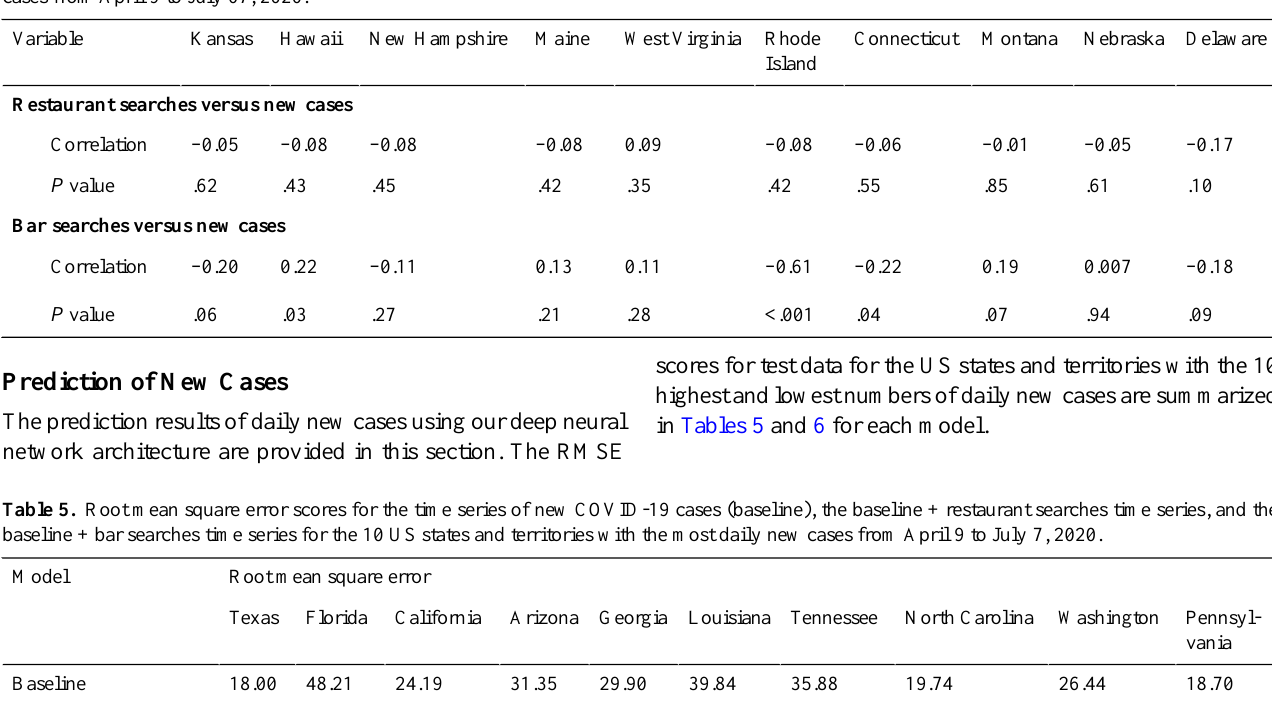
Table 4. Pearson correlations between search trends and daily new cases of COVID-19 for the 10 US states and territories with the fewest daily new cases from April 9 to July 07, 2020.